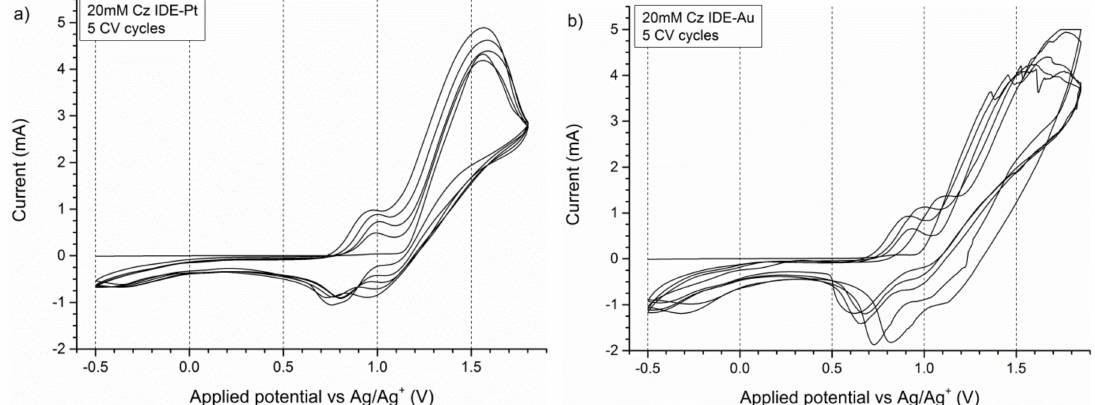
Figure A1. CV curves recorded during polymerisation CZ on transducers with interdigitated electrodes: